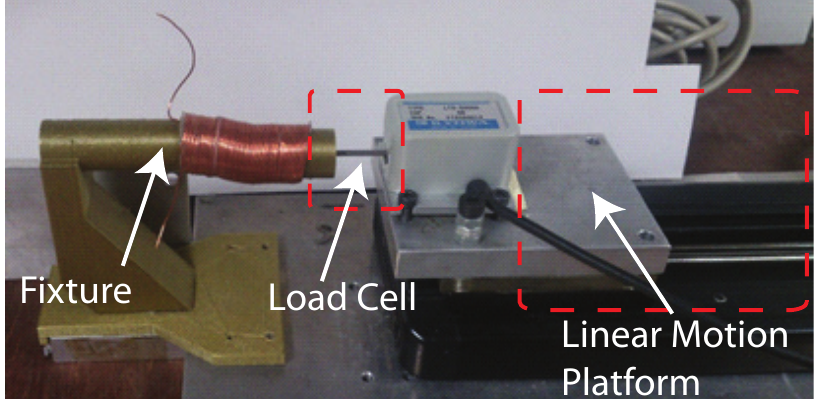
Figure 6. Experimental testbed for characterizing mechanical properties of proposed cylindrical DEA (stress-strain relation obtained by measuring axial deformations under external axial